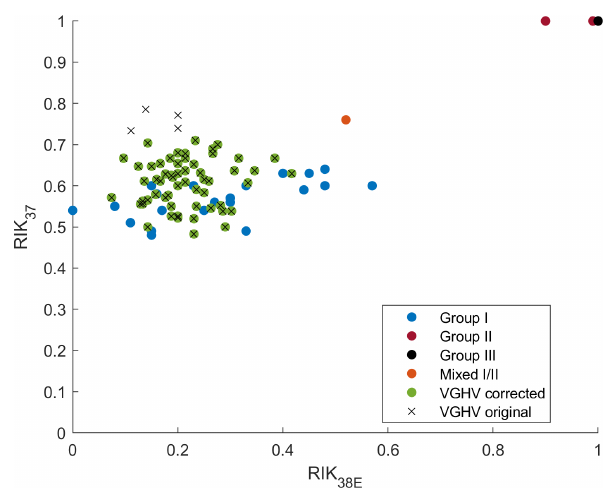
Figure A1. Comparison of RIK 37 and RIK 38E values for differ- ent alkenone distributions. Group I alkenone values (blue) and a mixed sample containing groups I and II (orange) are from the Northern Hemisphere and northern Alaska datasets (Longo et al., 2016, 2018). The values for groups II and III were determined from cultures (see Longo et al., 2018). The original VGHV alkenone dis- tributions are indicated by an X (these points only include samples where we were able to reliably identify and quantify C 38 : 3 Et and its isomer). The VGHV alkenones that were corrected for Group II are shown in green.